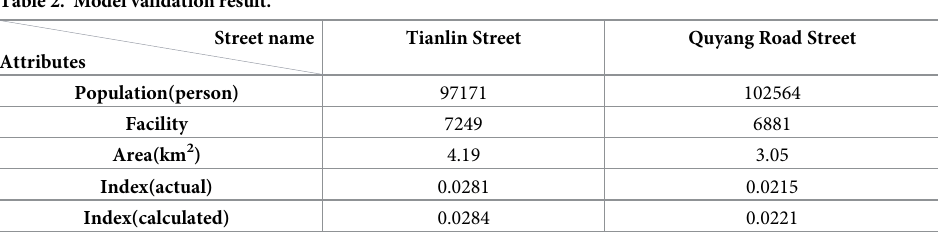
Table 2. Model validation result.